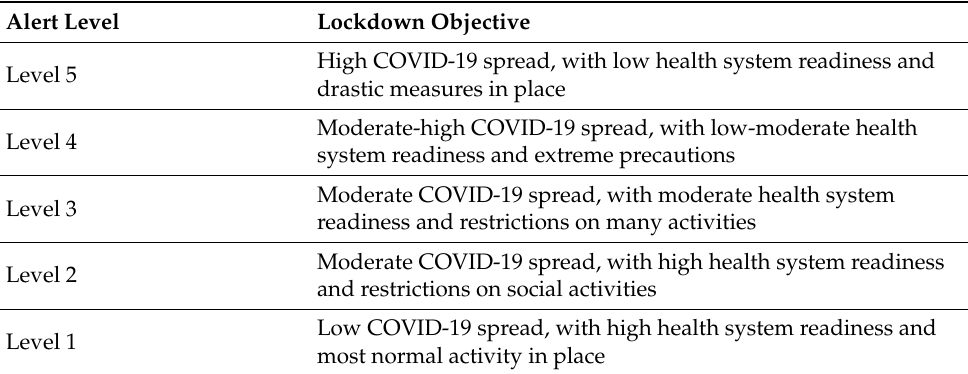
Table 1. Summary of COVID-19 lockdown alert levels in South Africa.